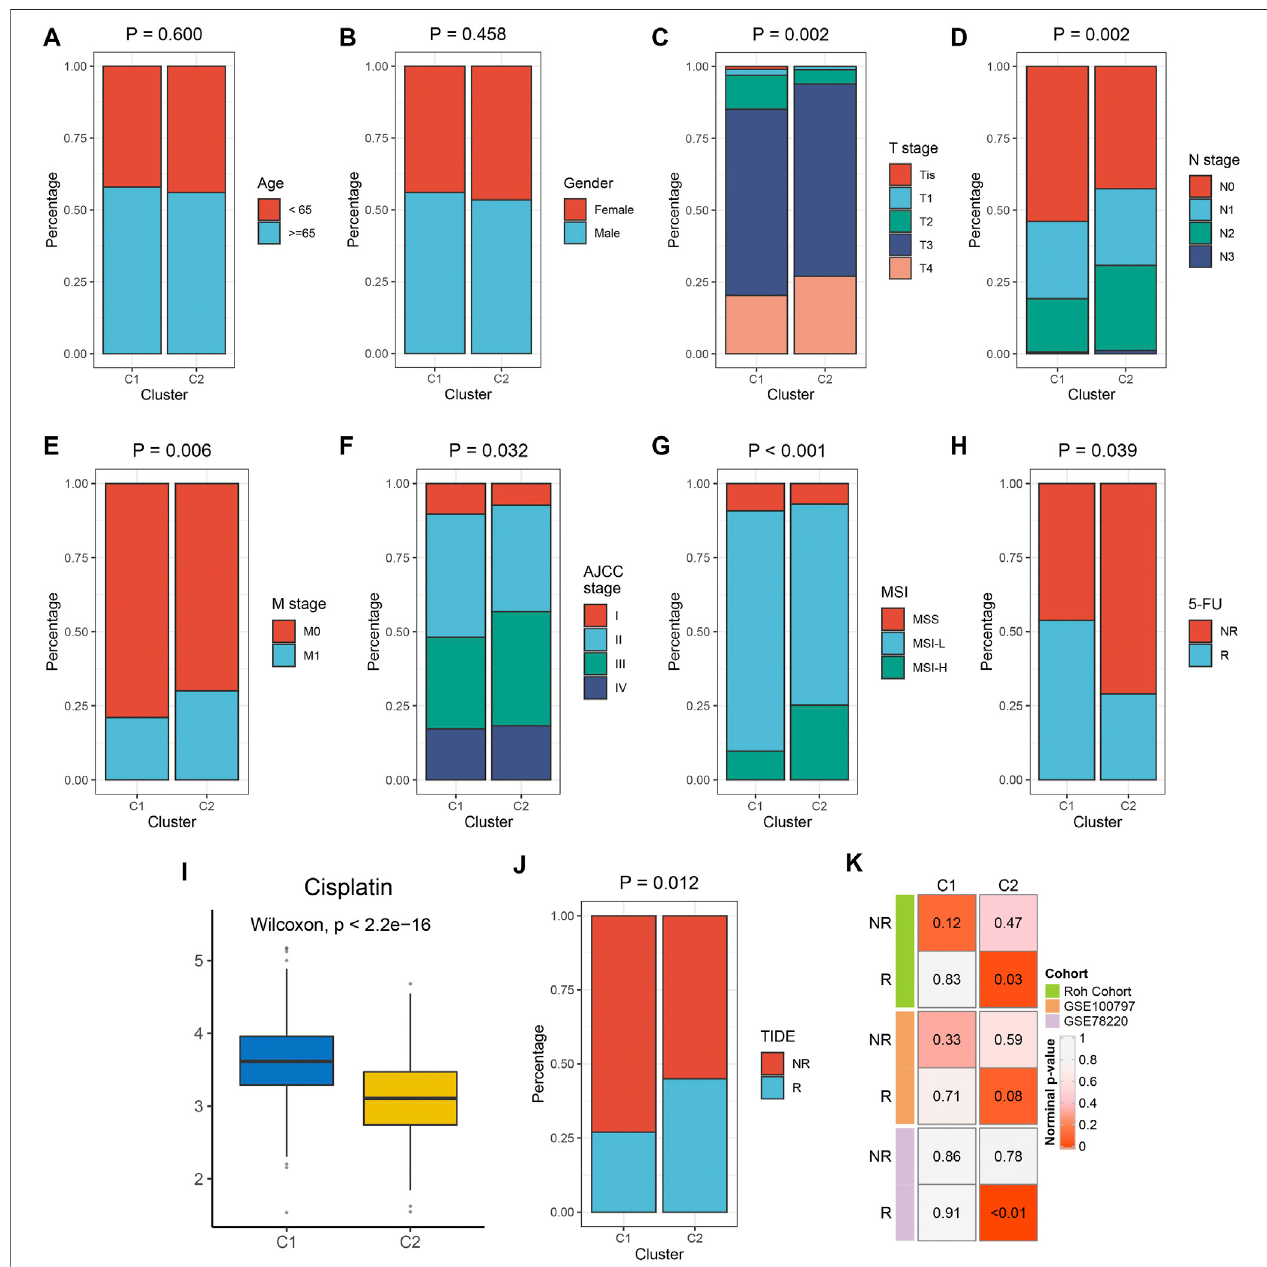
FIGURE 5 | The clinical signi fi cance of the two immune subtypes in the meta -GEO cohort. (A – H) Composition percentages of clinical characteristics such as age (A) ,gender (B) ,Tstage (C) ,Nstage (D) ,Mstage (E) ,AJCCstage (F) ,MSI (G) ,and5-FUresponse (H) betweenC1andC2. (I) TheIC50distributionofCisplatinbetween two subtypes. (J) Composition percentages of immunotherapy response estimated by TIDE algorithm between C1 and C2. (K) Submap analysis revealed that C2 was sensitive to immunotherapy.